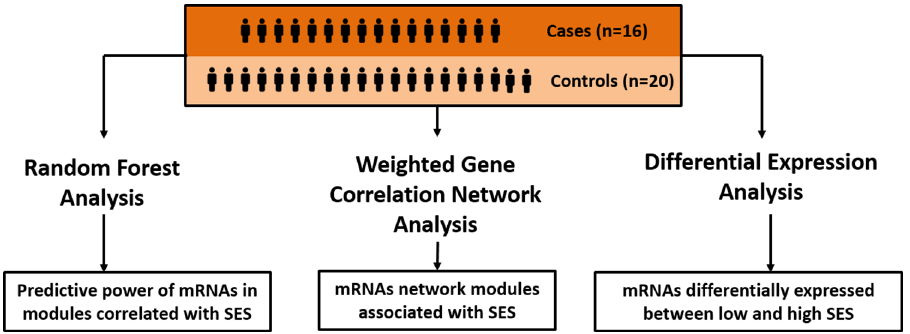
Fig 1. Graphical depiction of the strategy that uses 3 complementary